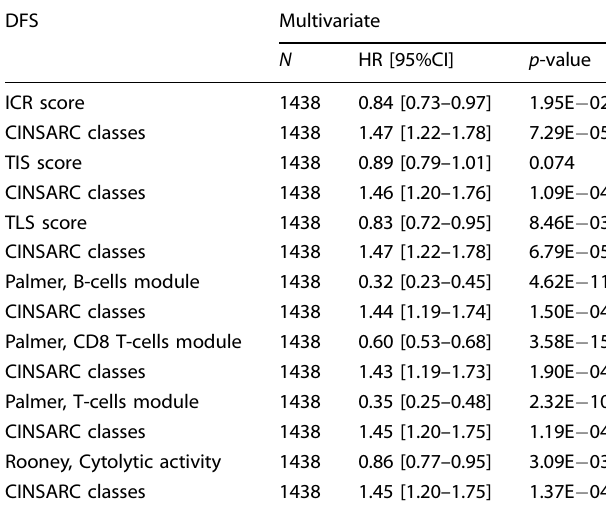
Table 4. Multivariate Cox regression analyses for DFS in Luminal B breast cancer including immune